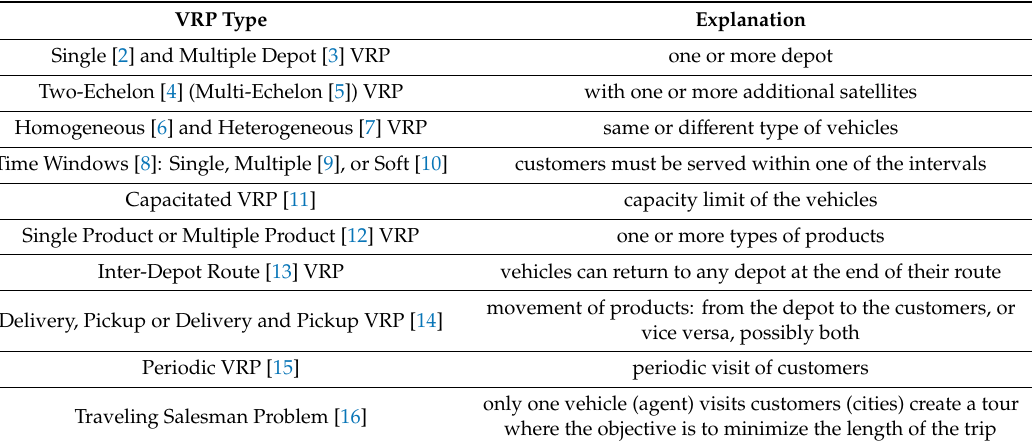
Figure 1. The basic vehicle routing problem (VRP). Table 1. The VRP types that contributed to our VRP system.